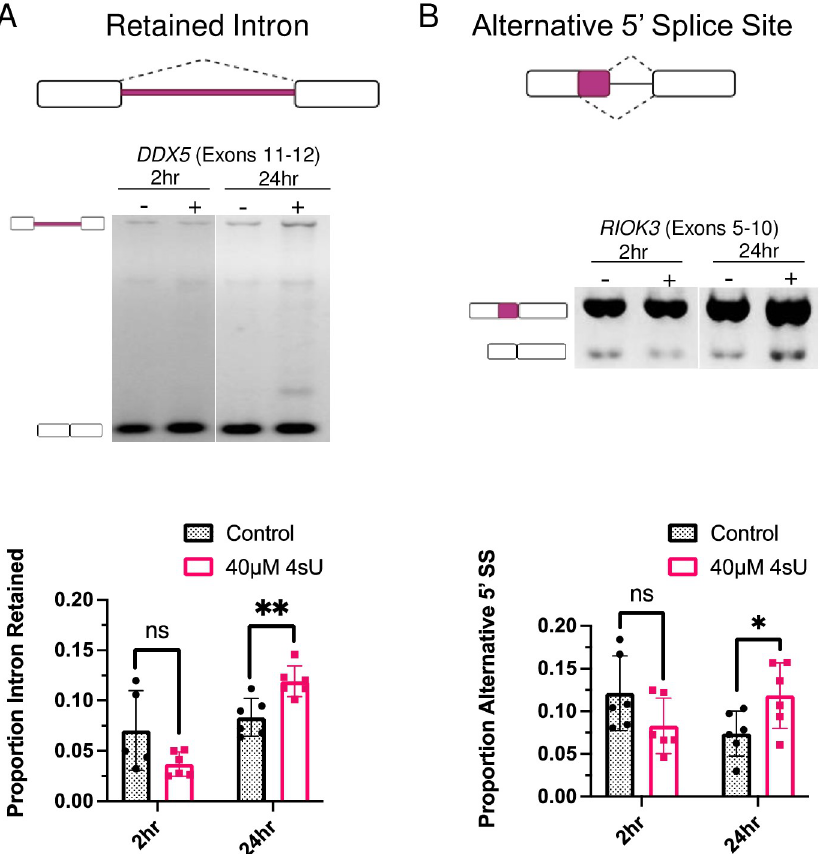
Fig 5. Alternative splicing behavior in cell culture in the presence of 4sU. PCR analysis of (A) intron retention in DDX5 (‘ns’, P = 0.08; ‘ �� ’, P = 0.0045) and (B) alternative 5’ss selection in RIOK3 (‘ns’, P = 0.012; ‘ �� ’, P = 0.042). The cartoon to the right of each image defines the alternative splicing products. cDNA samples from biological triplicates were analyzed after 2 and 24 hours of 4sU